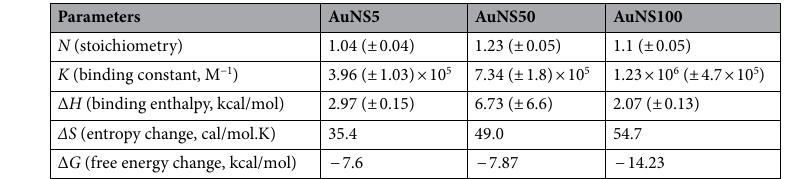
Table 2. Thermodynamics of binding of PIMT to AuNSs of different sizes.